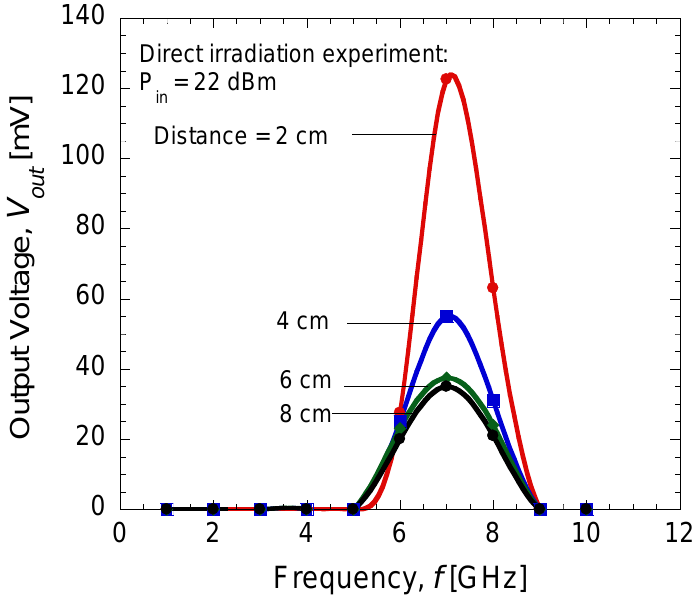
Figure 11. Rectified output voltage at input power of 22 dBm with different